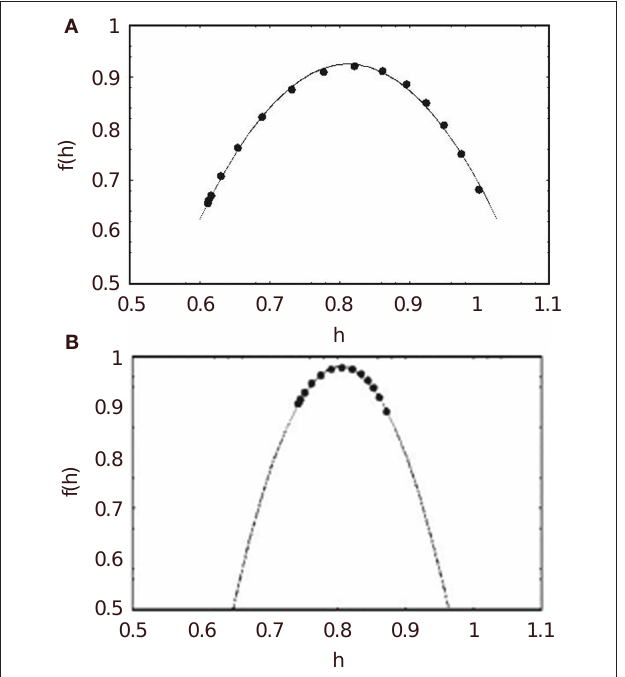
Figure 7 | The average multifractal spectrum for middle CBF time series is depicted by f ( h ). (A) The spectrum is the average of ten time series measurements from five healthy subjects (filled circles). The solid curve is the best least-squares fit of the parameters to the predicted spectrum using Eq. 48. (B) The spectrum is the average of 14 time series measurements of eight migraineurs (filled circles). The solid curve is the best least-squares fit to the predicted spectrum using Eq.